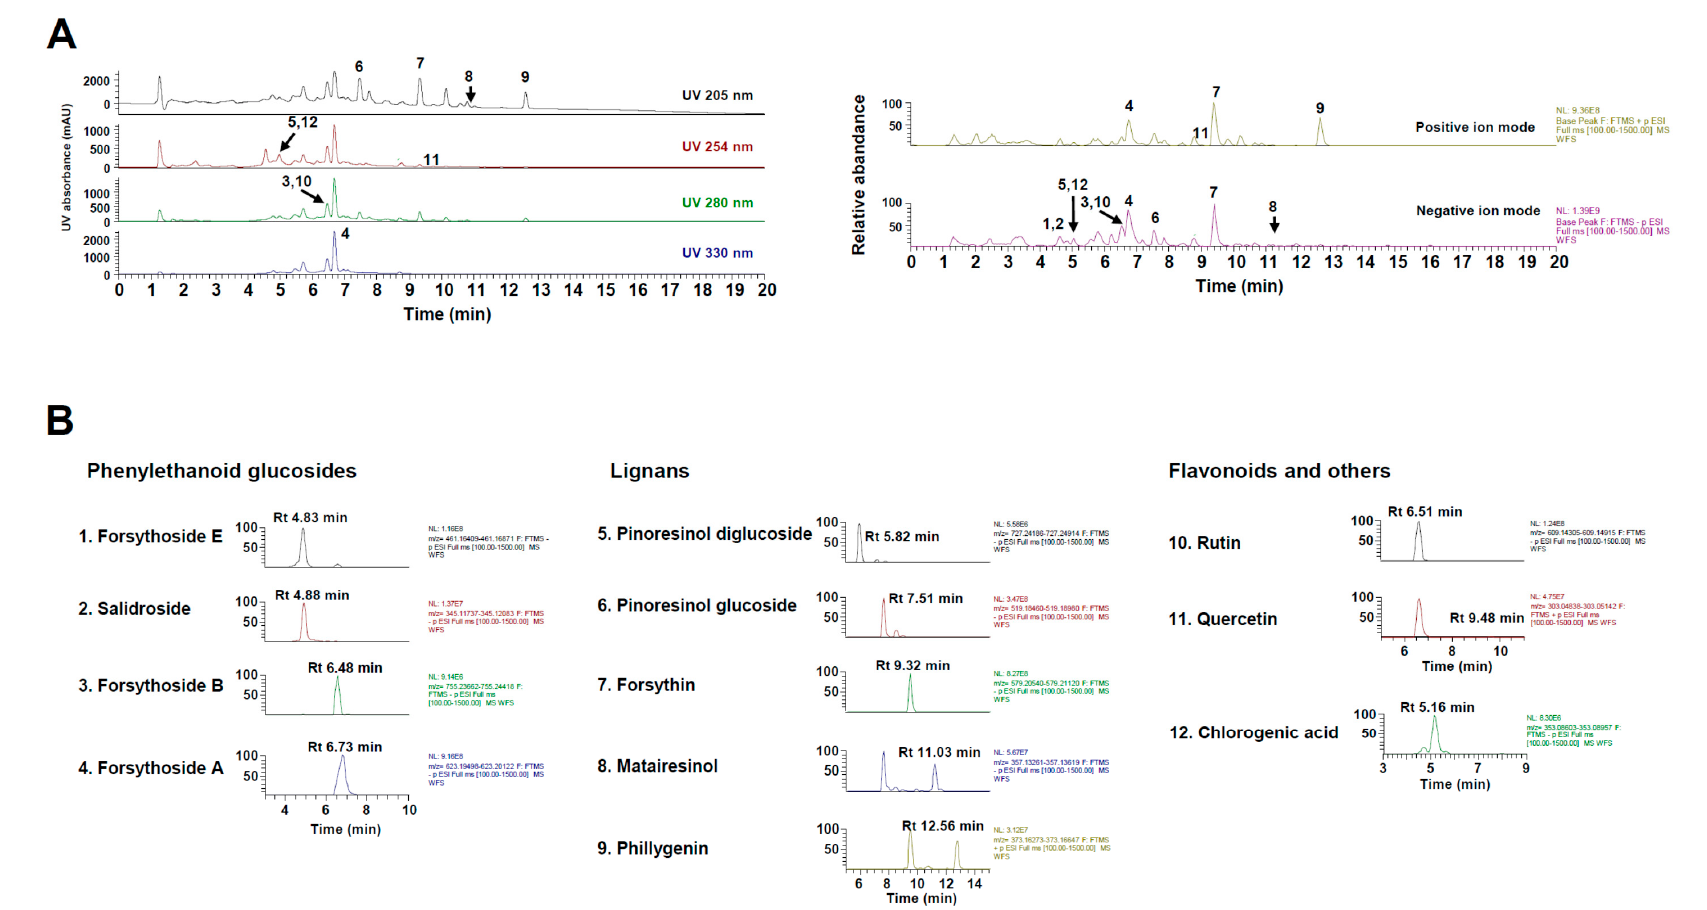
Figure 3. Ultrahigh-performance liquid chromatography–tandem mass spectrometry (UHPLC–MS/MS) analysis of WFS. ( A ) Ultraviolet and base peak chromatograms. ( B ) Extracted ion chromatogram of identified phytochemicals. UV, ultraviolet; Rt, retention time.